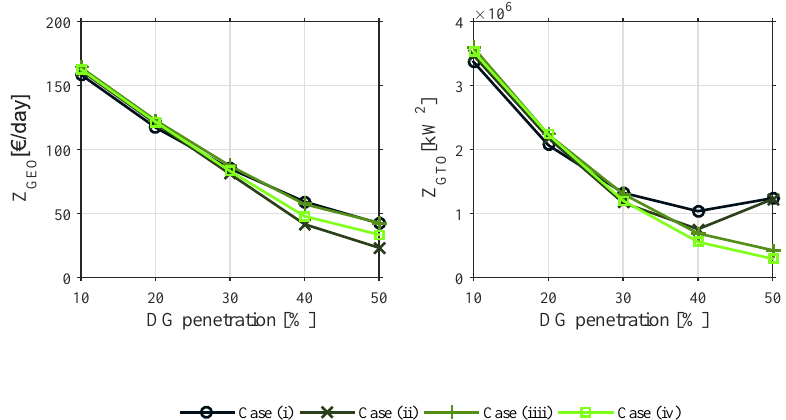
Figure 11. The operational costs of the DN for diverse DG penetration